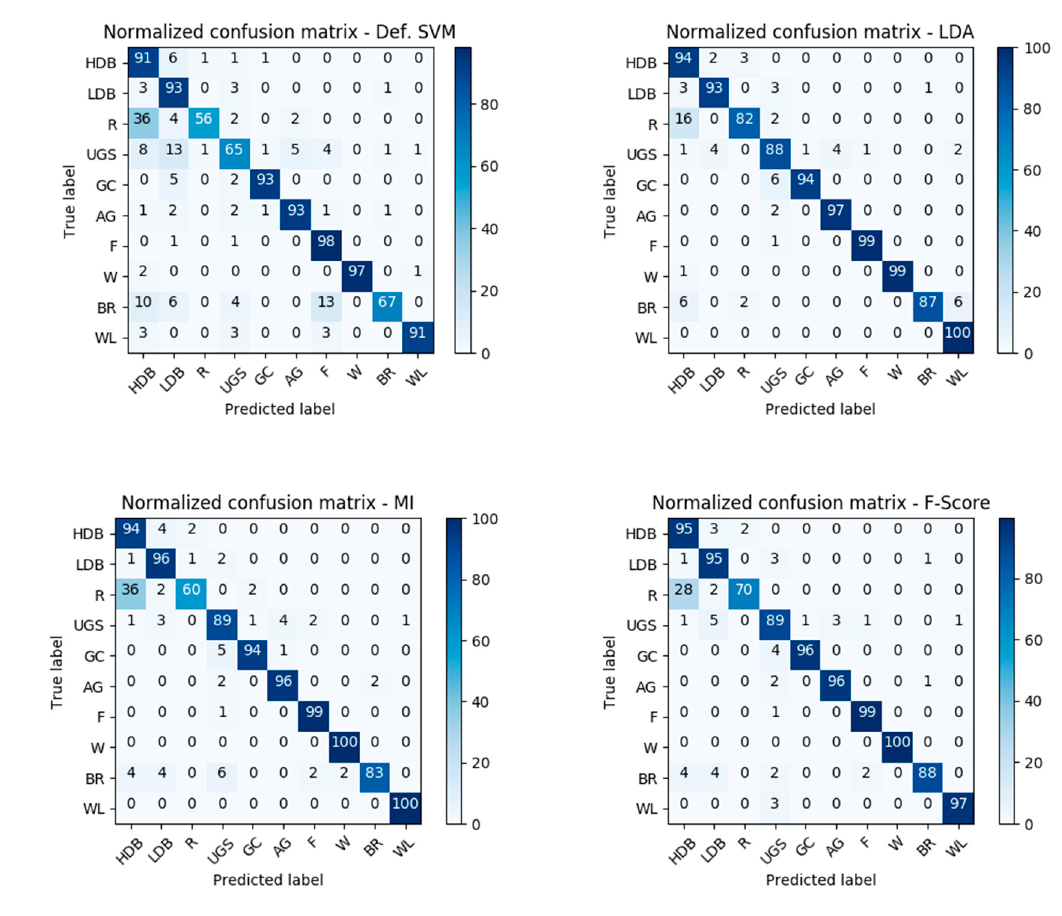
Figure 7. Normalized confusion matrices of the predictions on testing data